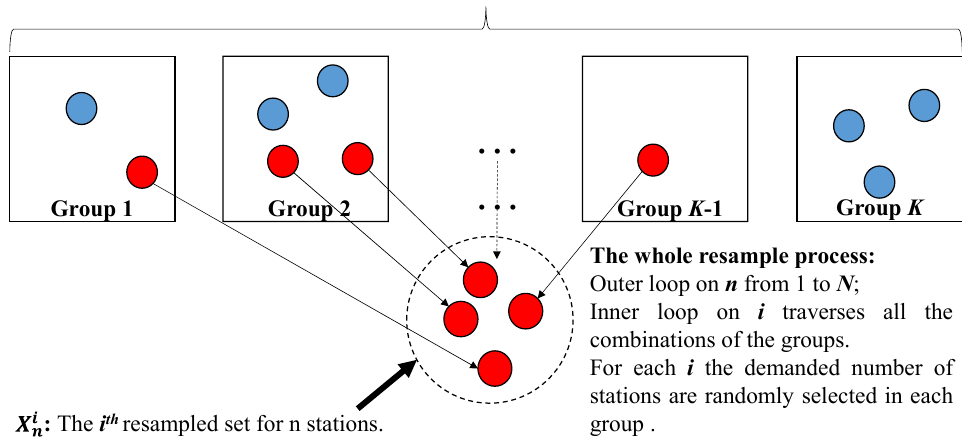
Figure 1. Framework of the resample processes of the bootstrap method.